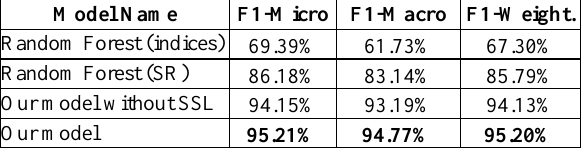
Table 4. Performance Comparison under temporal and spatial variance